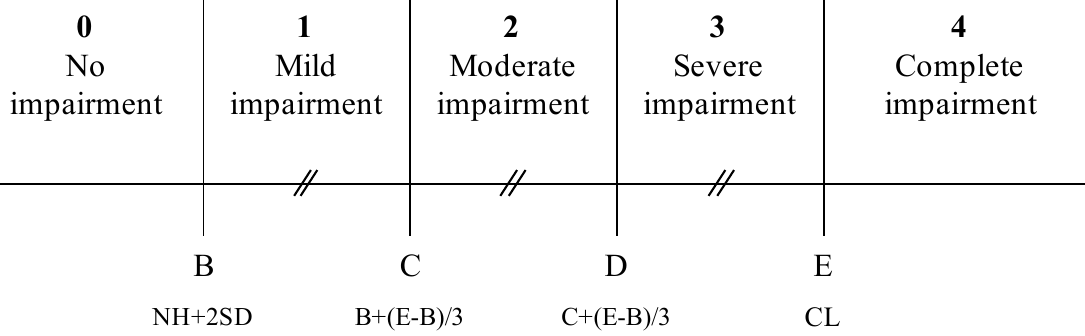
Figure 1. Schematic of the levels of impairment according to the ICF classification of localization ability. NH: Normal Hearing, CL: Chance level of the setup.